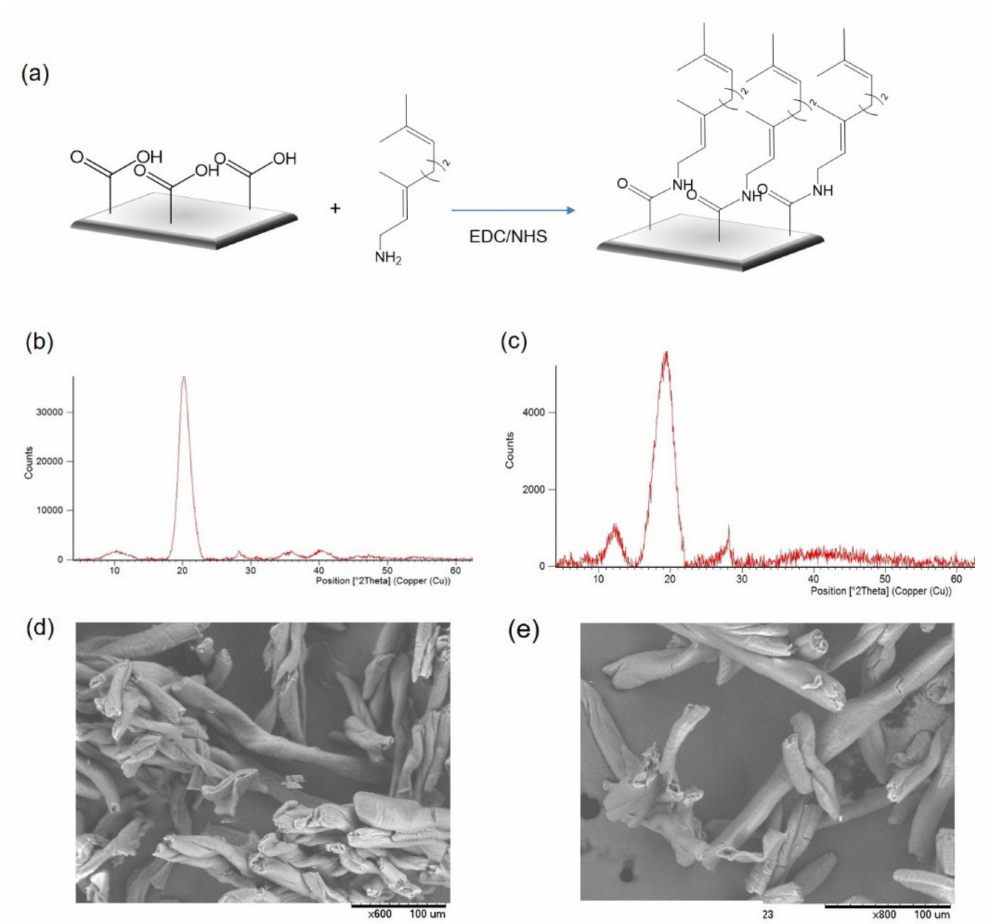
Figure 2. Geranyl functionalized materials synthesis. ( a ) Scheme of the process. ( b ) XRD patterns of CM. ( c ) XRD pattern of CM–geranyl support. ( d ) SEM image of CM. ( e ) SEM images of